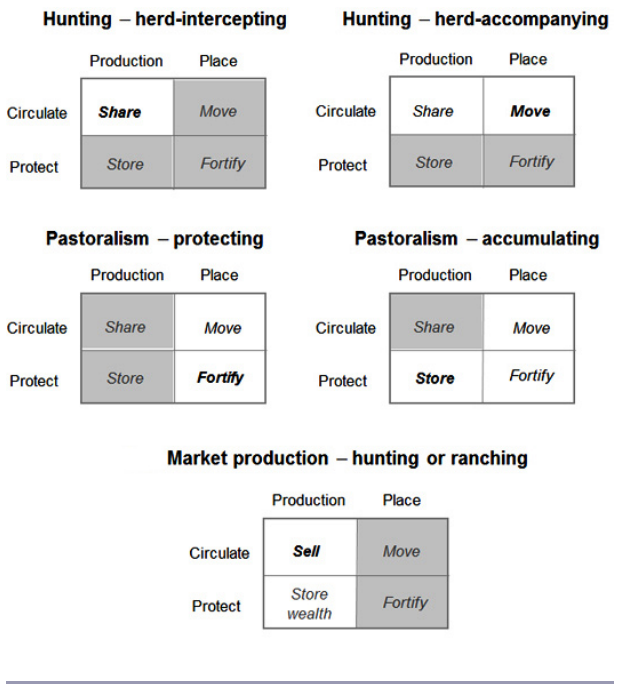
Fig. 3. Human–Rangifer system states. Each state relies on a different mix of strategies for mitigating environmental uncertainty. (Most prominent strategy for each state noted in boldface; less prominent strategies are grayed